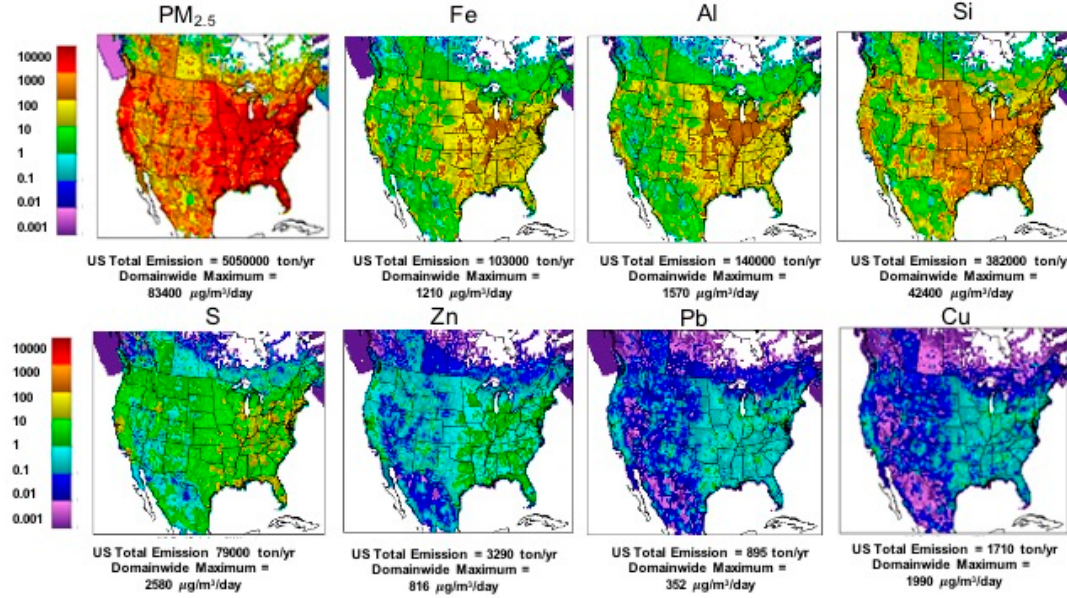
Figure 1. Maps of the United States from the first National Emissions Inventory PM 2.5 measured at ambient monitoring sites across the U.S. It depicts the total emissions (ton/year) as well as the ug/m 3 /day of PM 2.5 , and the trace elements and metals found in AP (air pollution), including Fe, Al, Si, S, Zn, Pb, and Cu. Levels of Fe, Al, Si, and S were among the highest, with lower exposure levels for Zn, Pb, and Cu. Modified from Reff et al., 2009 [83].